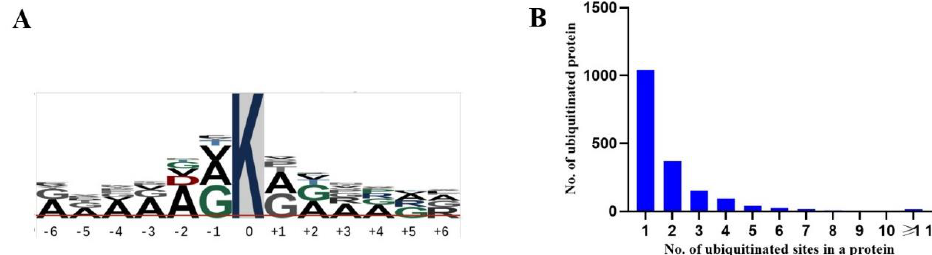
Figure 6. Consensus Kub motif and ubiquitination frequency analyses: ( A ) Amino acid preference around Kub sites; and ( B ) the number of Kub sites per protein.